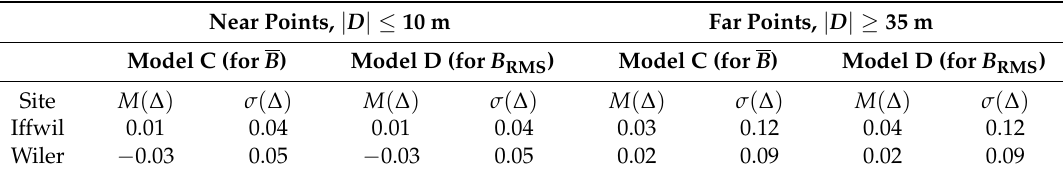
Table 4. Statistics (mean M ( ∆ ) and standard deviation σ ( ∆ ) ) of the difference between model and measurement, separately for near and far points for models with the